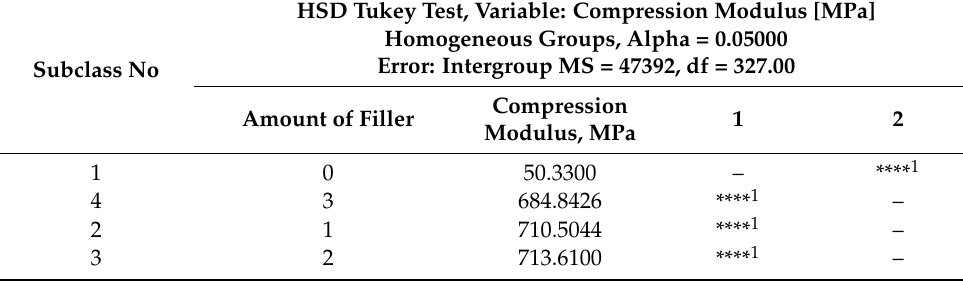
Table 7. Homogeneous groups isolated in the Tukey post-hoc test for the amount of filler.